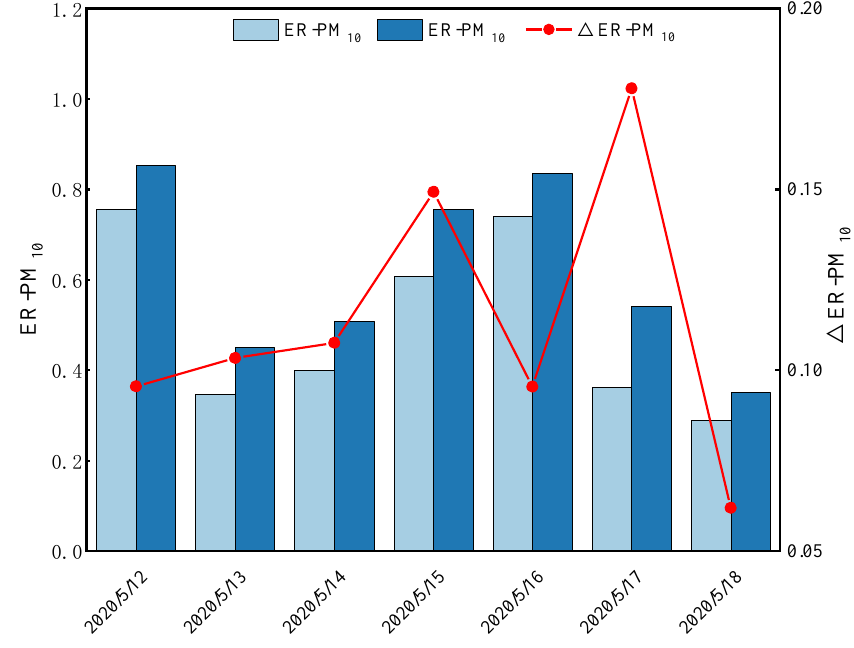
Figure 6. The excess mortality caused by PM 10 between the two sampling sites.